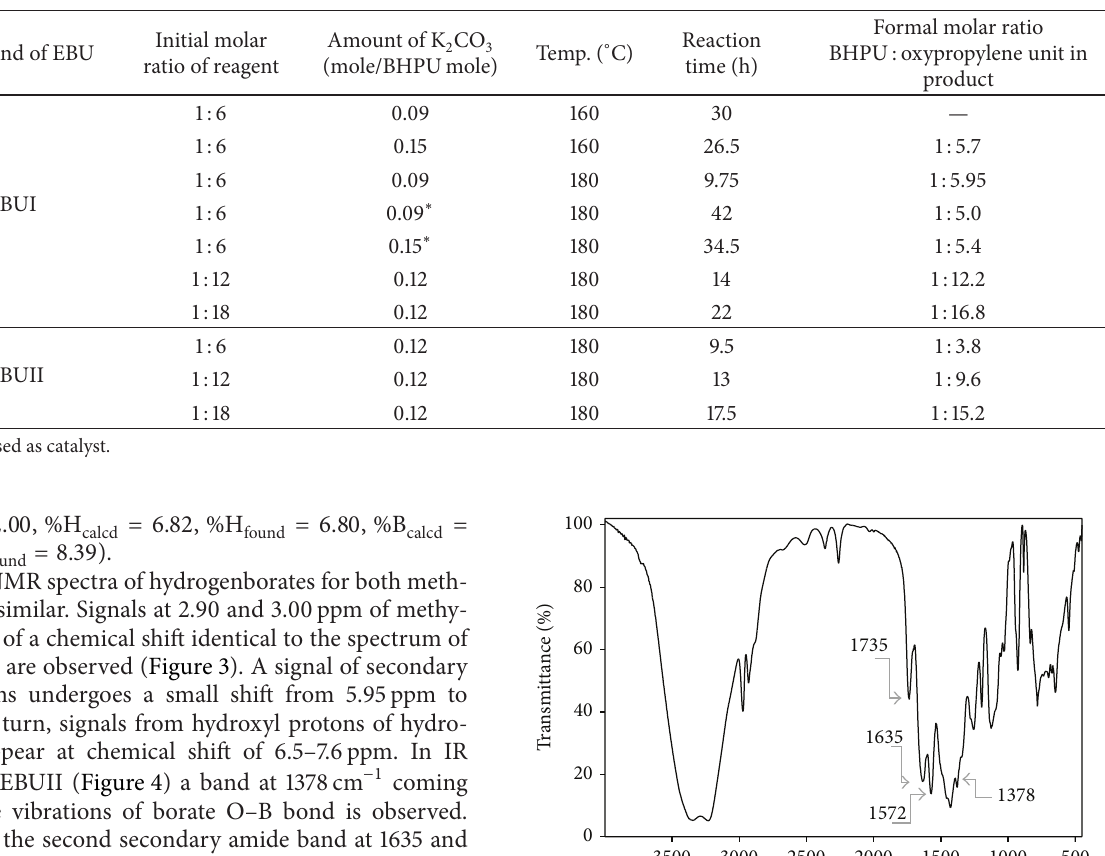
Figure 3: 1 H-NMR spectrum of EBUII: (a) without D 2 O and (b) with D 2 O addition. Table 2: Reaction conditions of EBUI and EBUII with PC.